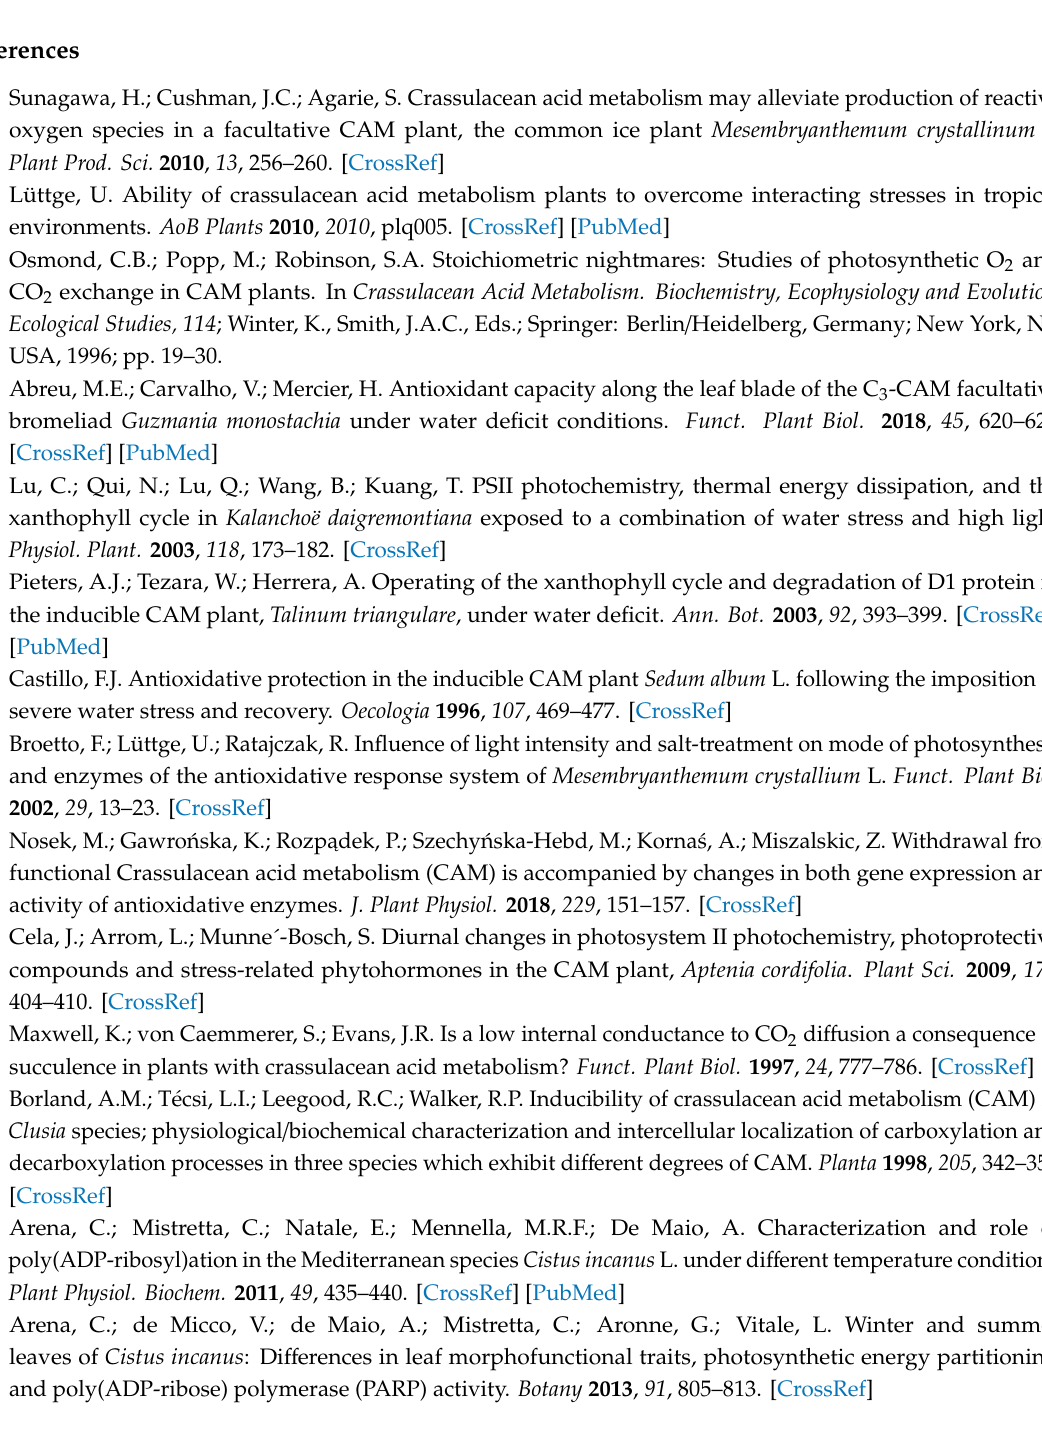
Table S1: Coe ffi cients of correlation (Pearson’s test) among the leaf investigated